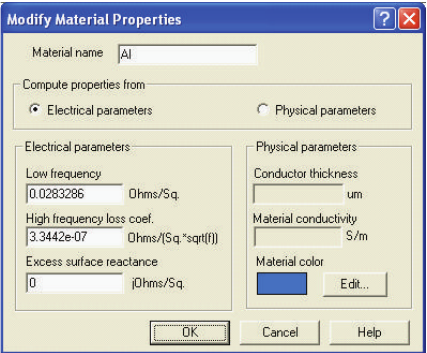
Figure 5: The electrical parameters of conductive material (Al) including high frequency loss coe ffi